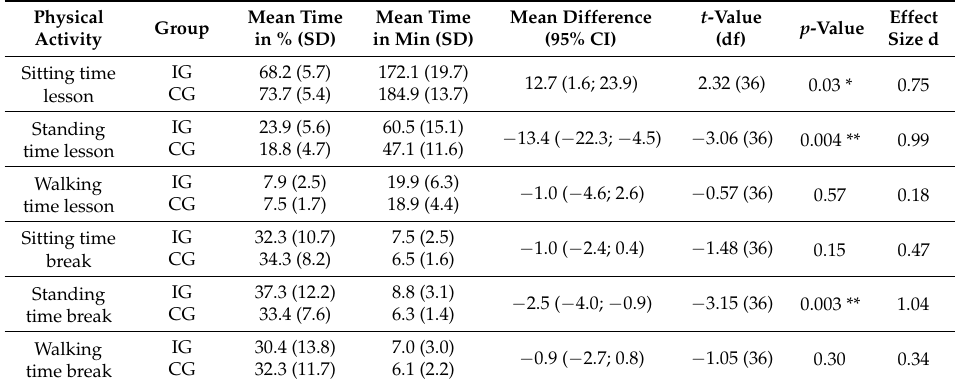
Table 2. Statistical values for daily sitting time, standing, and walking time during lessons and breaks measured by ActiGraph in IG ( n = 19) and CG ( n =